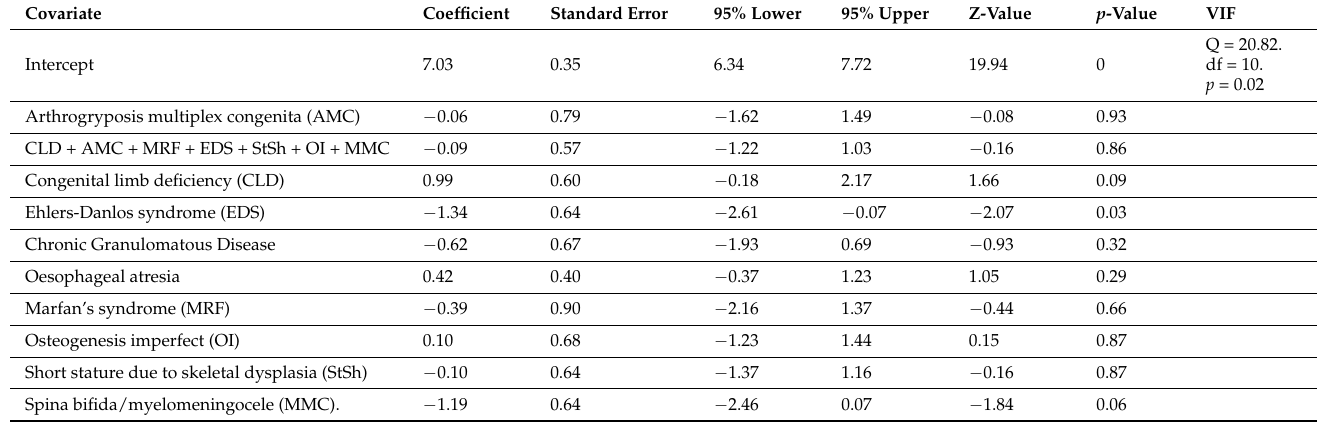
Table 8. Meta-regression by rare